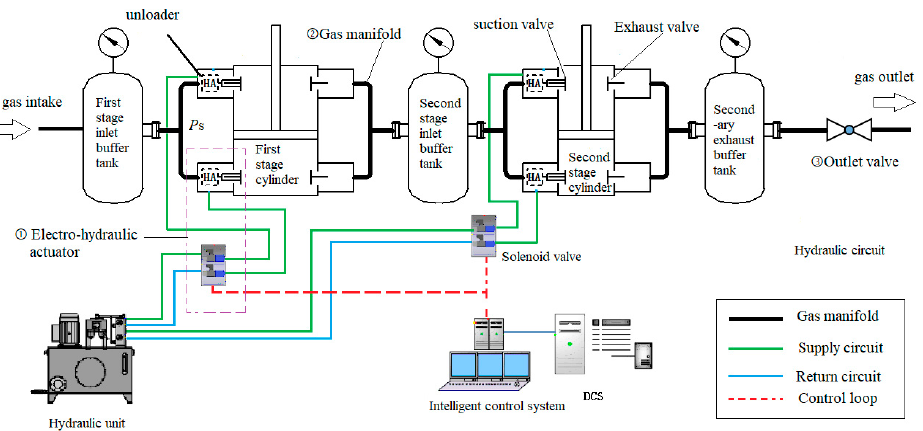
Figure 2. The variable capacity reciprocating compressor pressure system.